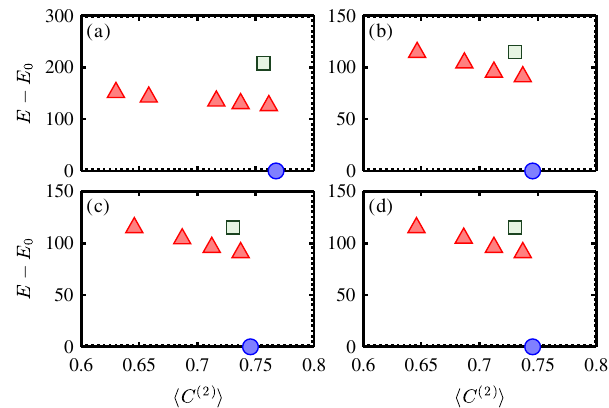
FIG. 12. Dispersion relation for m=g ¼ 1 . 6 , N ¼ 50 , x ¼ 150 , (d). The blue dot indicates the ground state, the red triangles the vector states, and the green square the scalar